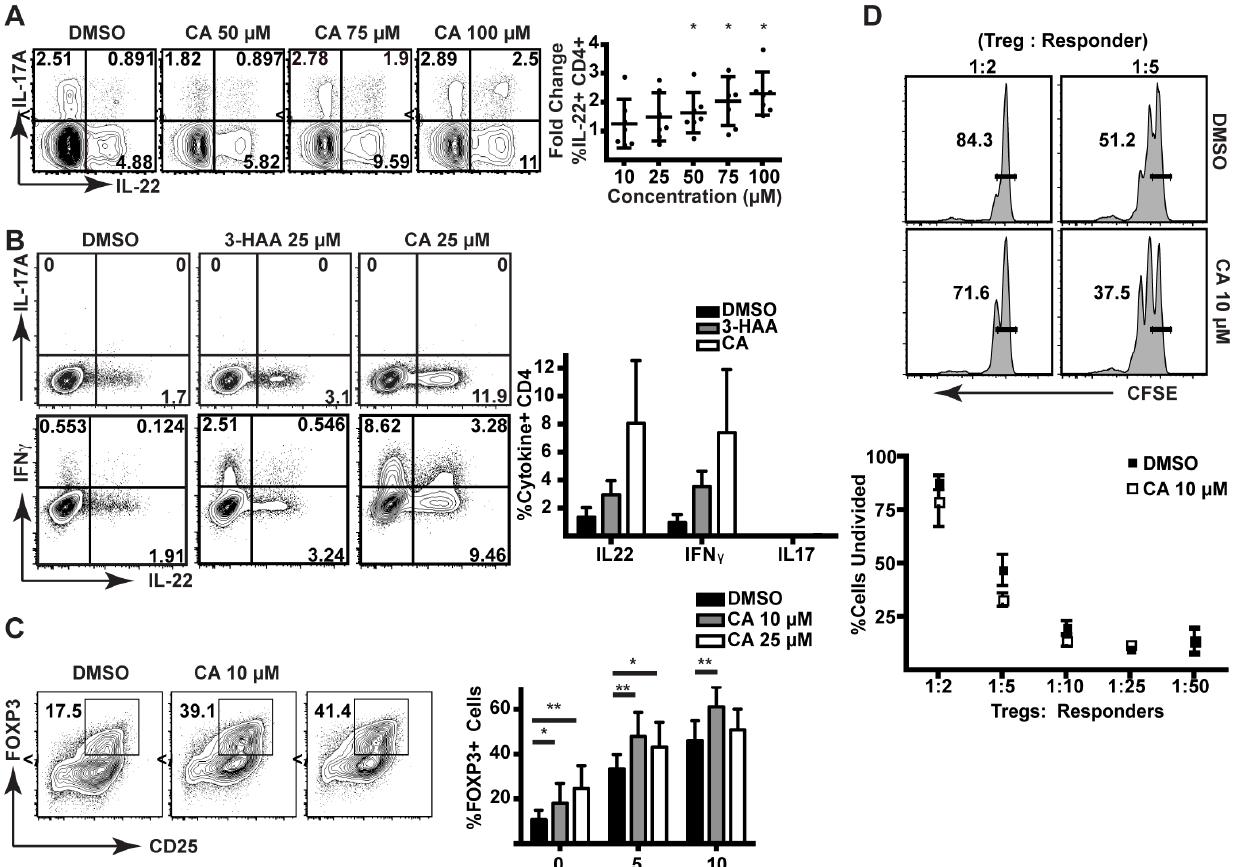
Figure 5. CA increases the differentiation of IL-22 + human CD4 + T cells invitro . (A) Flow cytometric analysis of CD4 + T cells from human PBMCs stimulated in the presence of DMSO or increasing doses of CA (left). Fold change in IL-22 production in CD4 + T cells from human PBMCs from multiple donors stimulated in the presence of CA versus DMSO control (right panel). Data were analyzed by Wilcoxon signed rank test for significant deviation from a theoretical median of 1.000. *p , 0.05. (B) Flow cytometric analysis of sorted naı¨ve human CD4 + T cells stimulated under polarizing conditions (with IL-21, IL-1 b , IL-23, anti-IFN c , anti-IL-4 and anti-IL12) with DMSO, 3-HAA (25 m M), or CA (25 m M). Data on IL-22, IFN c , and IL-17 production from three independent experiments are shown in the panel on the right. Error bars are SD. (C) Flow cytometric analysis of FOXP3 staining following stimulation of sorted naı¨ve human CD4 + T cells in the presence of DMSO or CA without addition of TGF- b . Quantification of %FOXP3 + CD25 + T cells of CD4 + cells from six donors in seven independent experiments (right panel) with increasing concentrations of TGF- b . Data were analyzed by two-way ANOVA and Holm-Sidak multiple comparisons test. *, p , 0.05. **, p , 0.01. Error bars are SD. (D) Flow cytometric analysis of CFSE-labeled responder CD8 + T cells incubated with autologous Tregs generated in the presence of CA or DMSO control. Data are representative of three independent experiments.